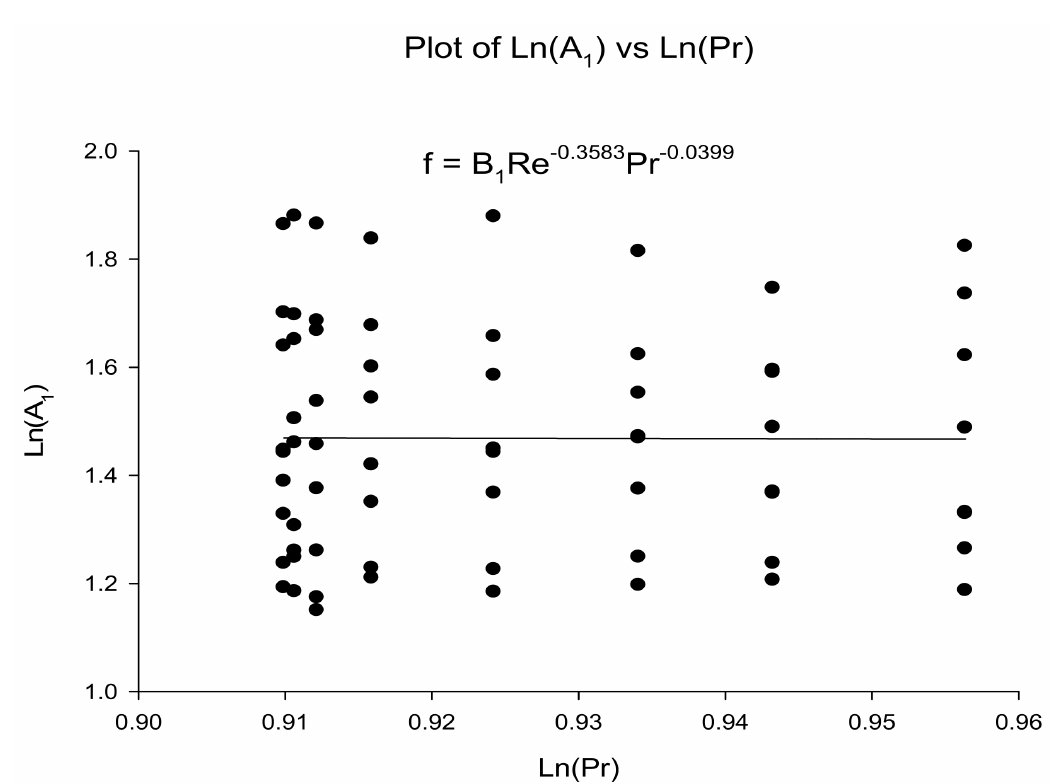
Figure 8. Experimental Variation of coefficient A1 and Prandtl